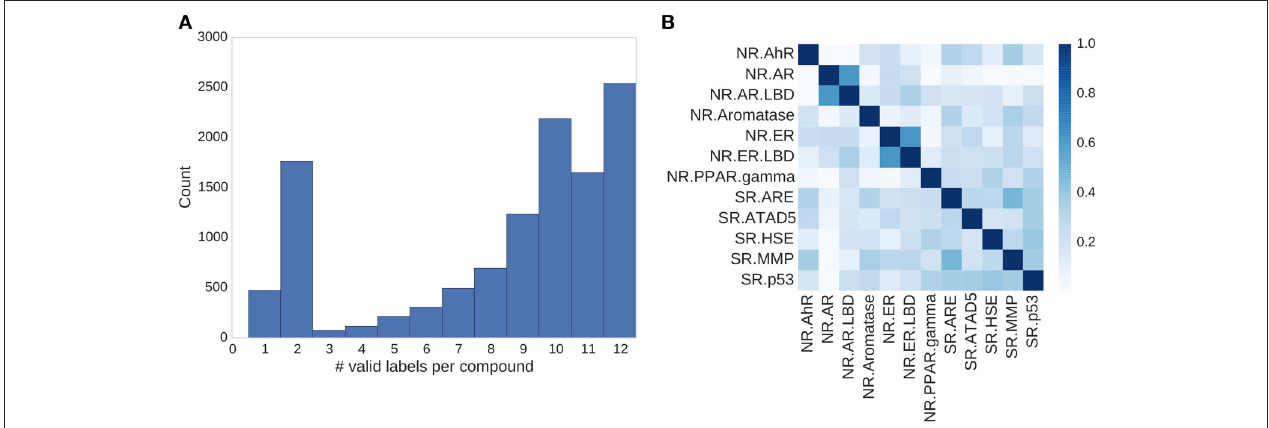
FIGURE 4 | Assay correlation. (A) Histogram showing the number of unambiguous assay label assignments per compound. Only ≈ 500 compounds had a label for just one assay, more than half (54%) of the compounds had labels for 10 or more tasks. (B) Absolute correlation coefficient between the different assays of the Tox21 challenge.